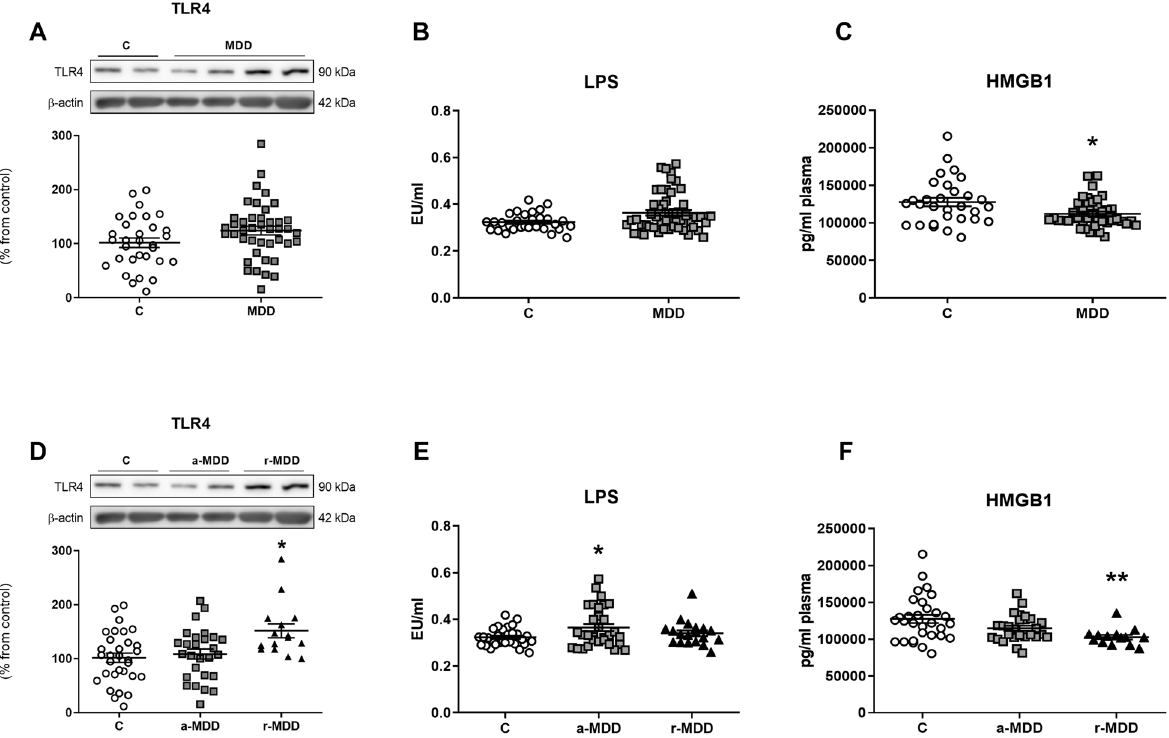
Fig. 2 Effects of the MDD on the innate immune pathway. TLR-4 protein expression in PBMCs ( A ) and LPS plasma levels ( B ) were not affected by the MDD. Plasma levels of HMGB1 decreased in the MDD group ( C ). TLR-4 expression was not altered in the a-MDD group and was increased in the r-MDD group compared with HC ( D ). LPS plasma levels augmented in the a-MDD and were not affected in the r-MDD group compared with HC ( E ). HMGB1 plasma levels decreased in the r-MDD group compared with HC ( F ). Data are expressed as mean ± standard error of the mean (SEM). In the western blots the densitometric data of the respective bands of interest are normalized by β -actin (lower band). Samples were from parallel experiments and that gels/blots were processed in parallel. An unpaired two-tailed t -test was performed when comparing two groups. For more than two groups comparisons, a one-way ANOVA with a Tukey post-hoc test was employed, and in those cases in which the data did not follow a Gaussian distribution, a nonparametric ANOVA with a Kruskal – Wallis test followed by a Dunn ’ s post-hoc test was performed. * p < 0.05, ** p < 0.01 vs. healthy controls